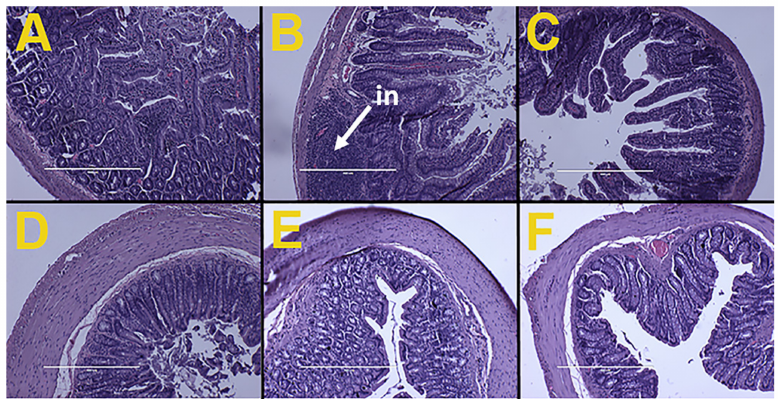
Figure 2. Effects of Kappaphycus on structure and inflammation in ileum (top row) and colon (bottom row) using hematoxylin and eosin stain in C rats ( A , D ), H rats ( B , E ), and HR rats ( C , F ).